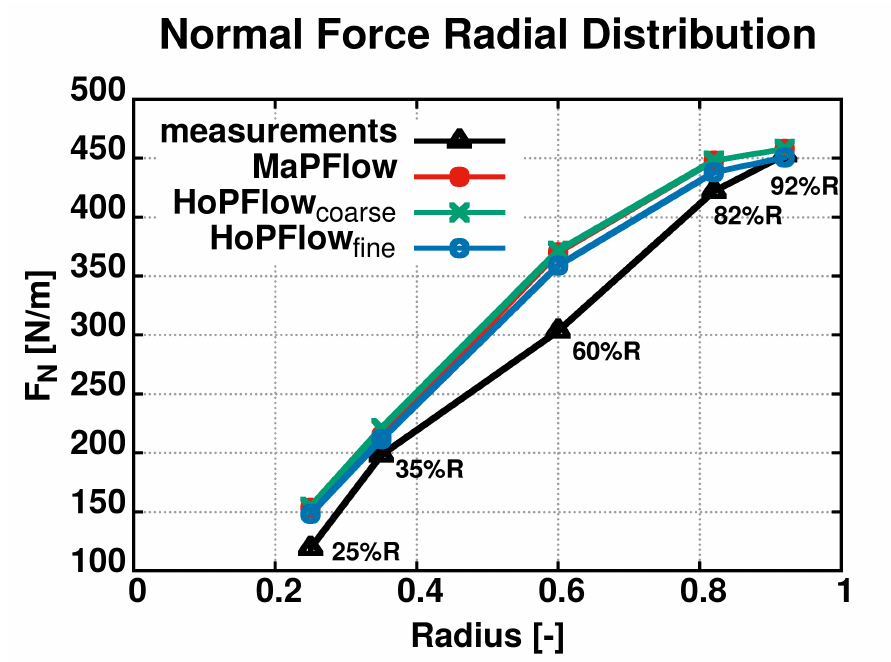
Figure 11. Radial distribution of normal forces. Comparison between experimental measurements and computational